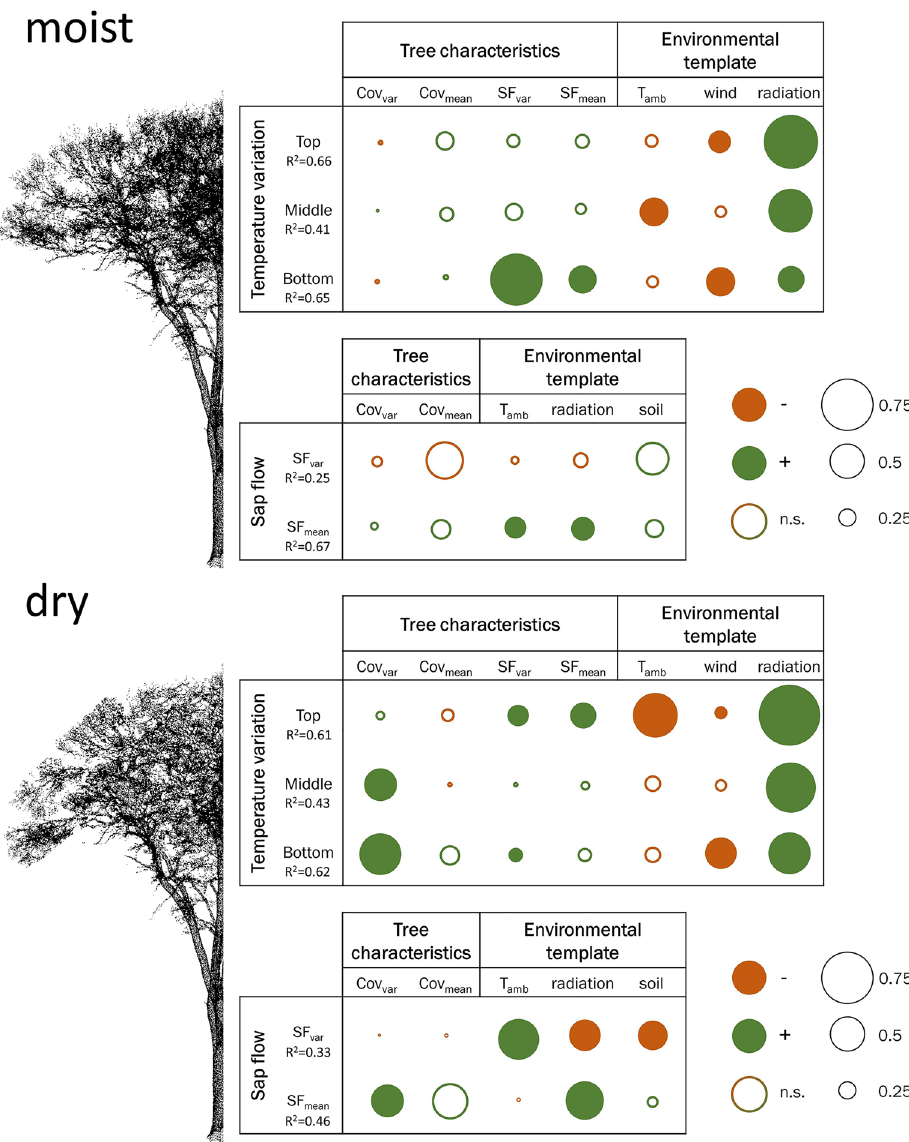
Figure 4. Graphical representation of estimated effect sizes of the biotic and environmental template on microclimatic variability between species (T var ) and on the moderating transpirational performance of trees under moist and dry conditions using the SEM framework. Circle diameters corresponds to the strength of the effect; positive relationships are color-coded in green, negative relationships in red; insignificant paths are indicated by open circles, significant paths by filled circles. The effects sizes of the indirect (via sap flow) and total effects on T var can be found in the supplement (Supplementary Tables S4–S6